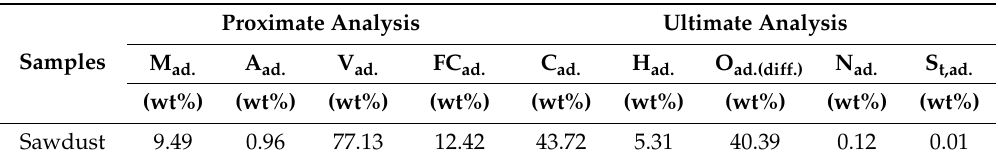
Table 1. Proximate and ultimate analysis of the origin sawdust sample. (Note: diff. = by difference, ad. = air dry basis.)